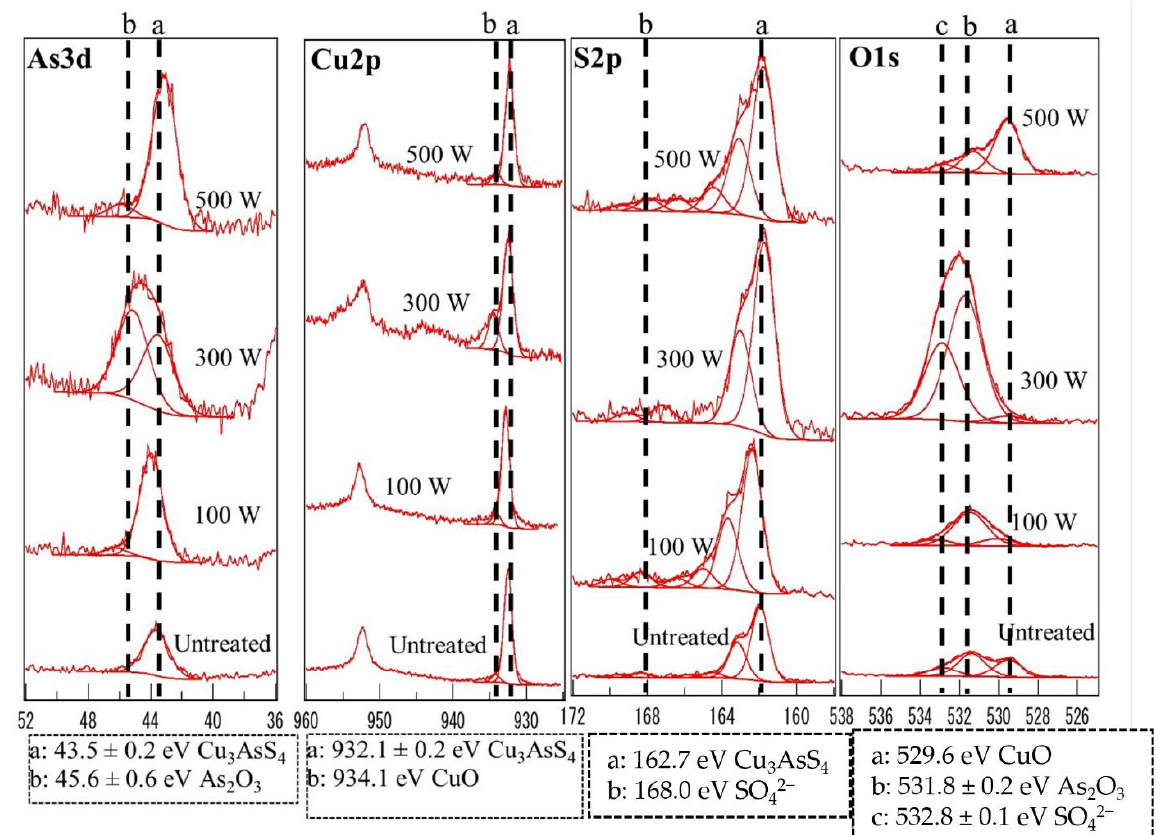
Figure 3. XPS spectra of enargite before and after microwave treatment for 60 s.